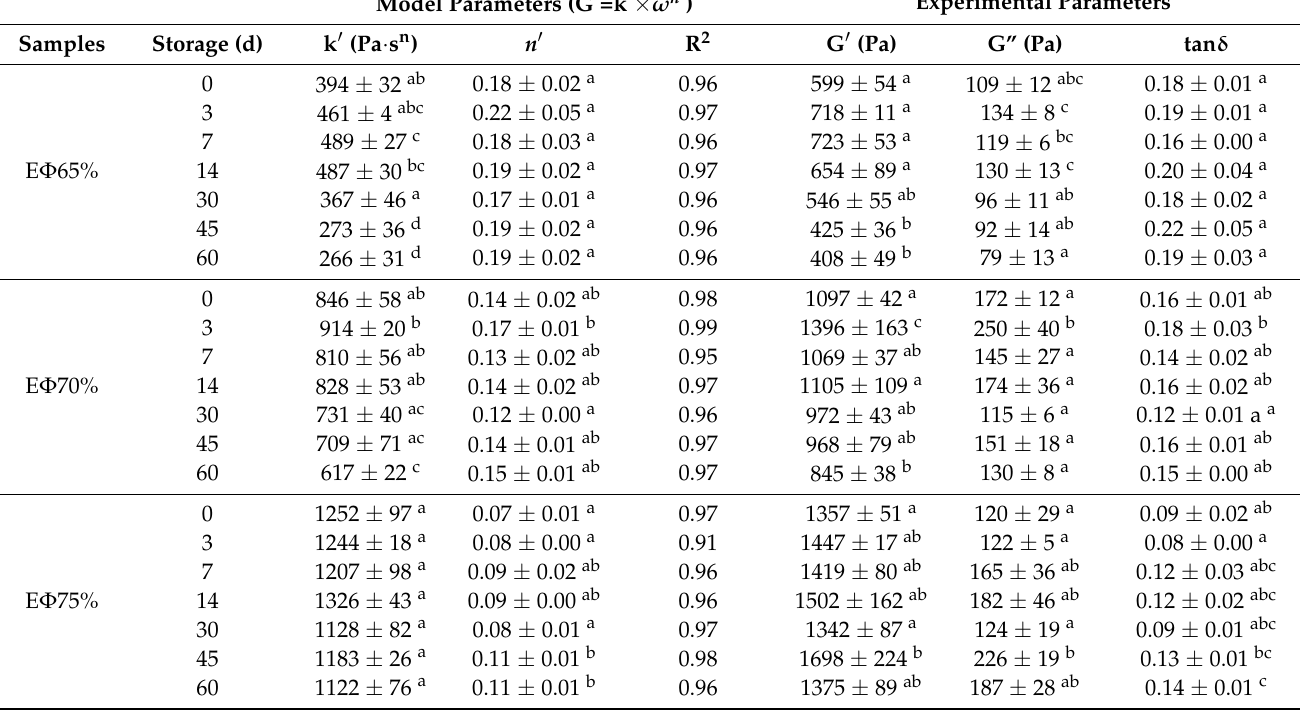
Table 4. Power law parameters (k (cid:48) and n (cid:48) ) for the storage modulus G (cid:48) throughout the 60 days of storage at 25 ◦ C and the storage (G (cid:48) ) and loss (G” LVR ) moduli; the loss-tangent (tan δ ) at a frequency of 1 Hz for samples stored at 25 ◦ C. Model Parameters (G ’ =k ’ × ω n ’ ) Experimental